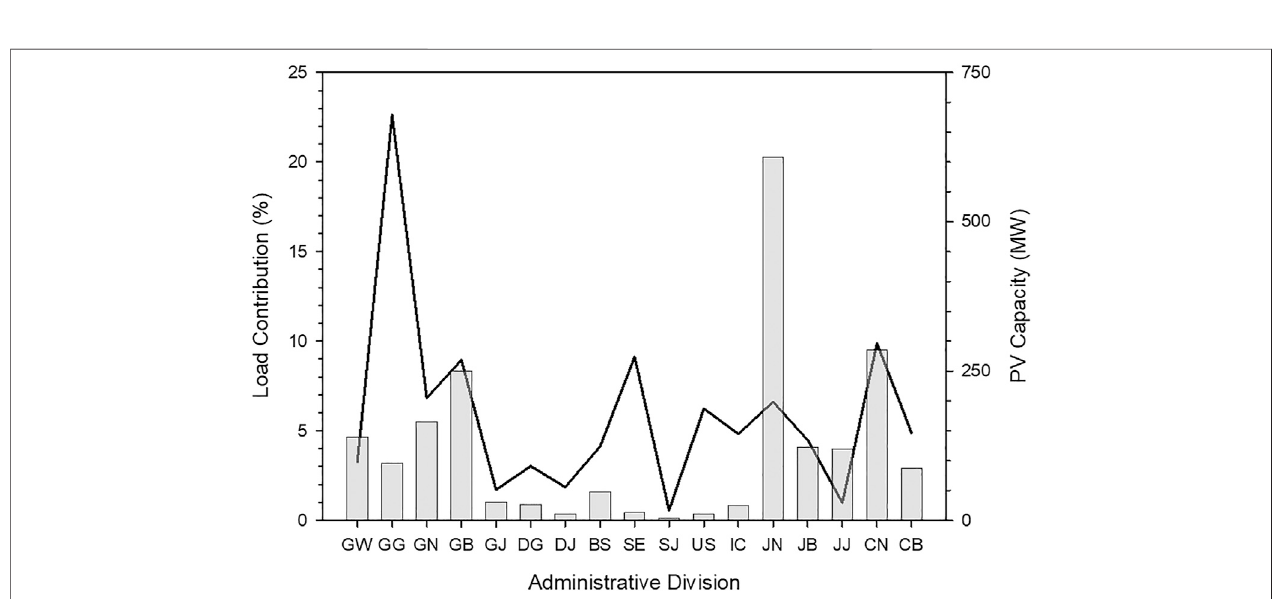
FIGURE 5 | Regional contribution of electricity load to national electricity load (solid line) and installed capacity of PV power plants (vertical bar) .